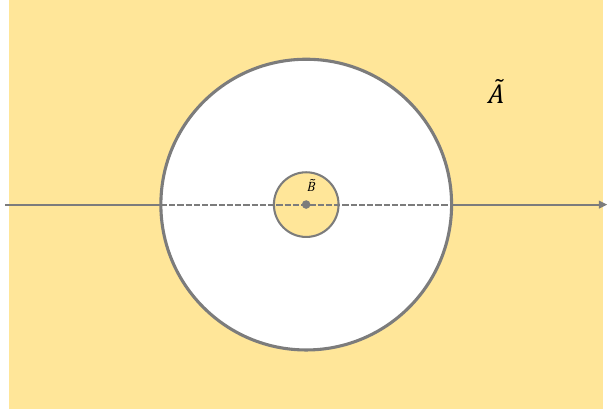
Figure 8 . Conformally equivalent configuration of two concentric